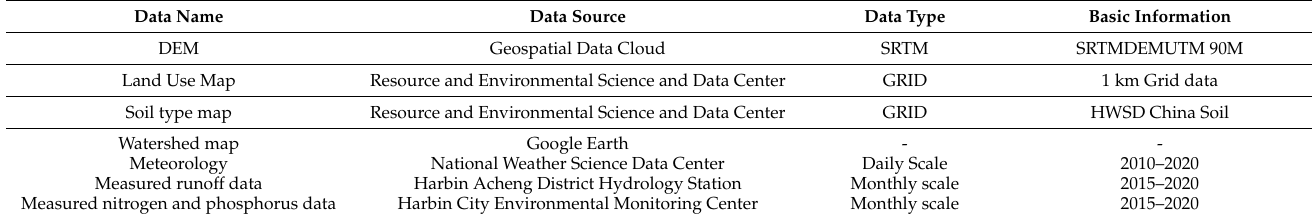
Table 1. Data sources and basic information.